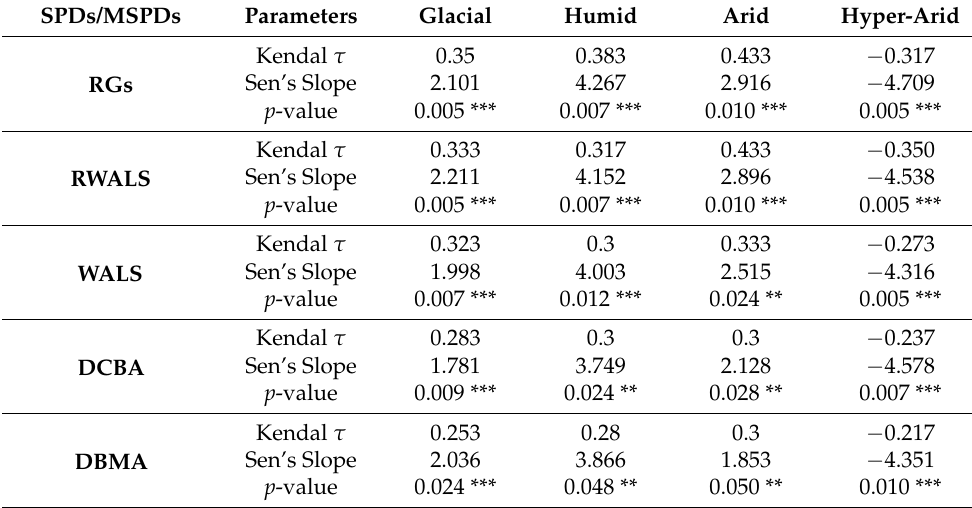
Table 8. MK trend and level of significance for SPI-3 estimated for RGs, SPDs, and MSPDs across all climate regions. The p -values less than 0.01, 0.05, and 0.10 show that the trend is significant at the significance level of 1%, 5%, and 10% and marked with ***, **, and *,